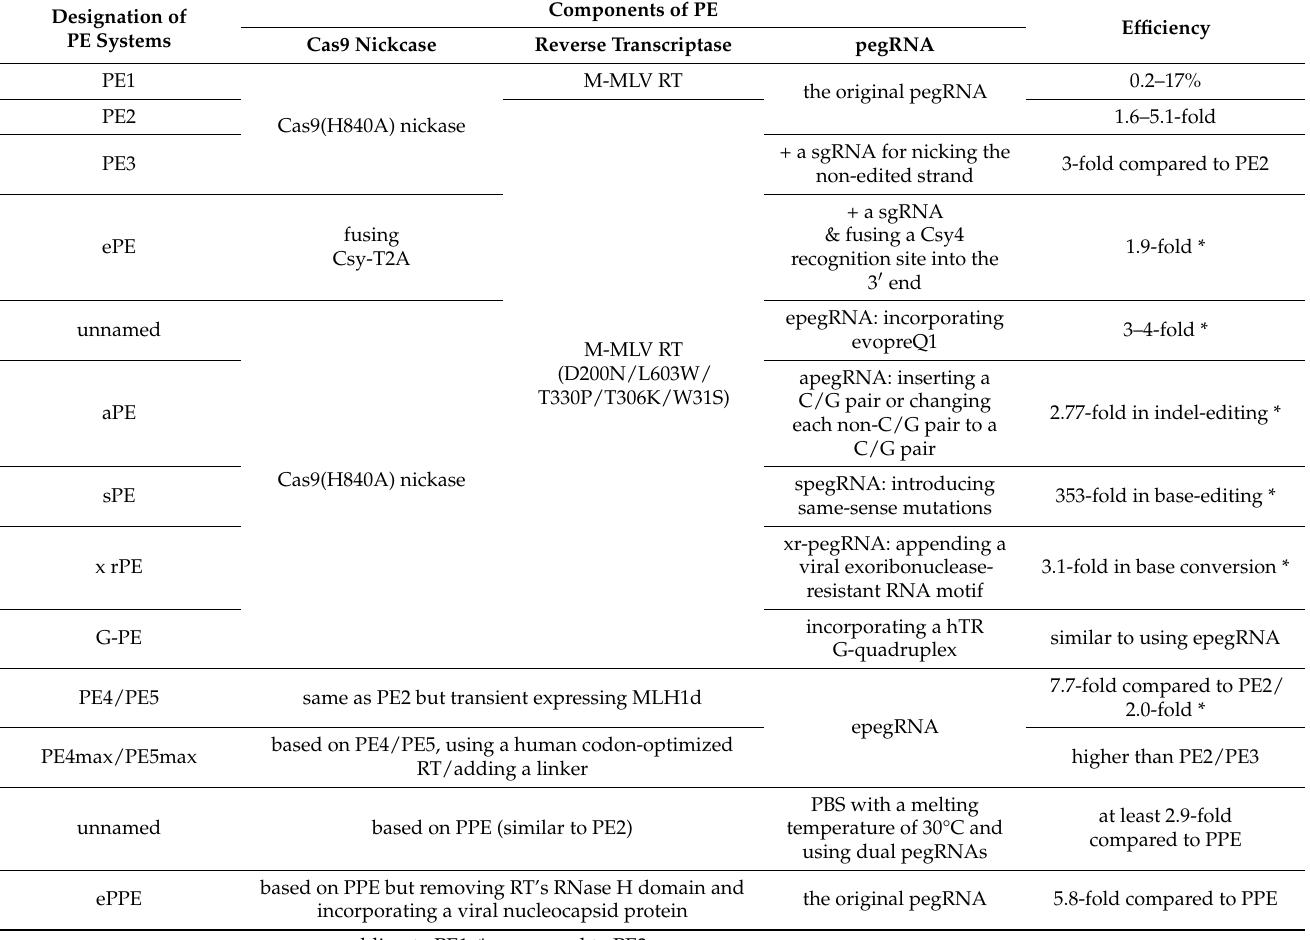
Table 1. Summarization for the refinement in